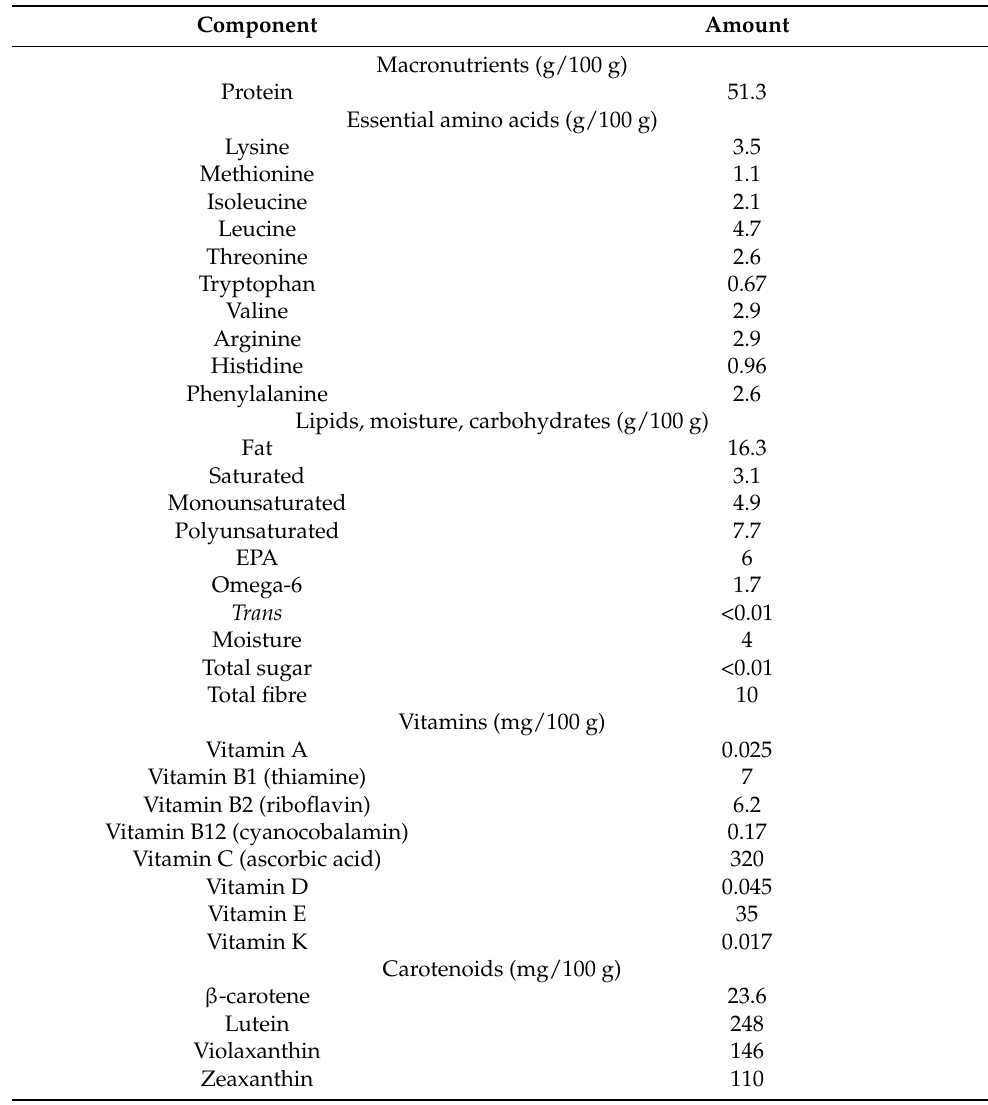
Table 1. Nutrient composition of Nannochloropsis oceanica algae